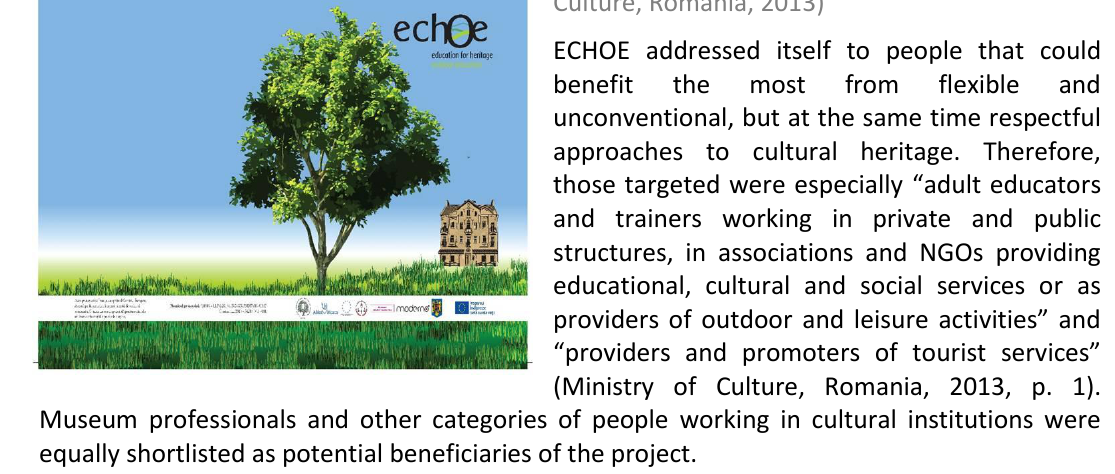
Figure 2: Front cover of the ECHOE (Ministry of Culture, Romania, 2013) ECHOE addressed itself to people that could benefit the most from flexible and unconventional, but at the same time respectful approaches to cultural heritage. Therefore, those targeted were especially “adult educators and trainers working in private and public structures, in associations and NGOs providing educational, cultural and social services or as